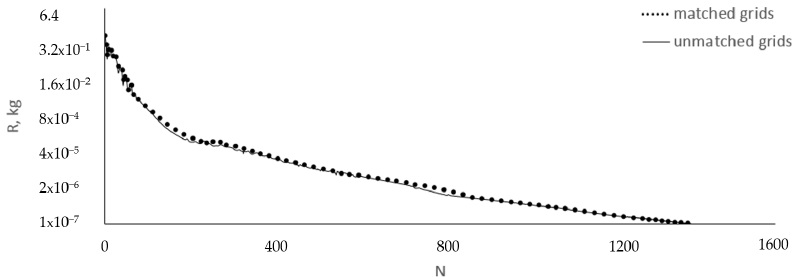
Figure 16. Convergence graph ( R is the mass discrepancy, N is the step number).